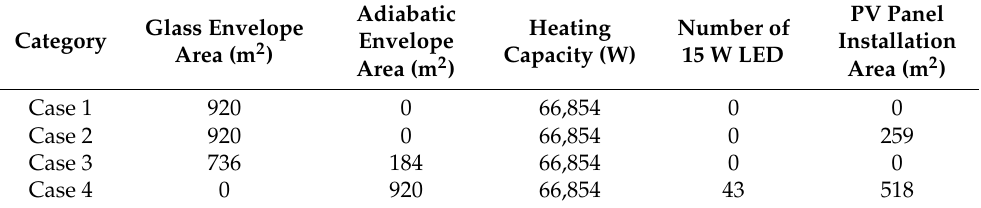
Table 4. Area per envelope, heating capacity, and lighting